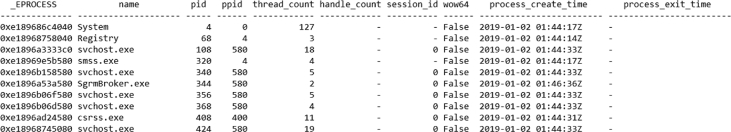
An example of a list of processes for a memory dump.